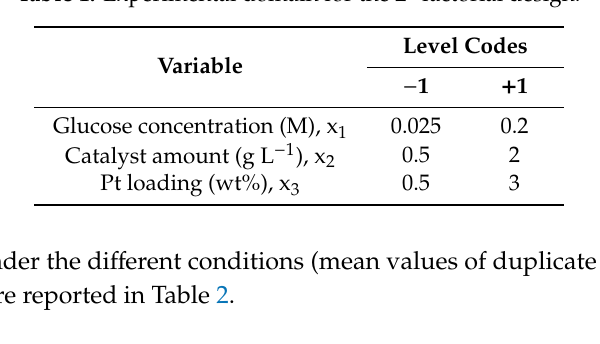
Table 2. Mean hydrogen evolution rates (HERs) obtained in the conditions of the experimental plan for both composite photocatalysts.